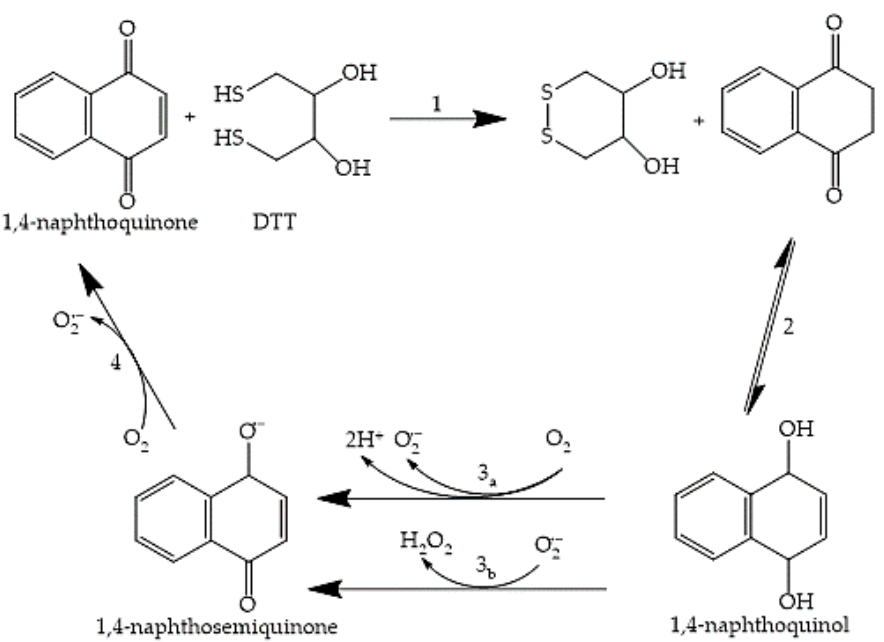
Figure 11. The reaction mechanism between DTT and 1,4-naphthoquinone (14NQ), including 1, 2, 3a, 3b and 4. Reaction 1 shows DTT readily forms a stable six membered ring with 14NQ reduced; Reaction 2 shows 14NQ rearranges to form the 1,4-naphthoquinol; Quinols form a free radical-semiquinone through Reaction 3a or 3b and the semiquinone is transformed to the original quinone by Reaction 4 [65].